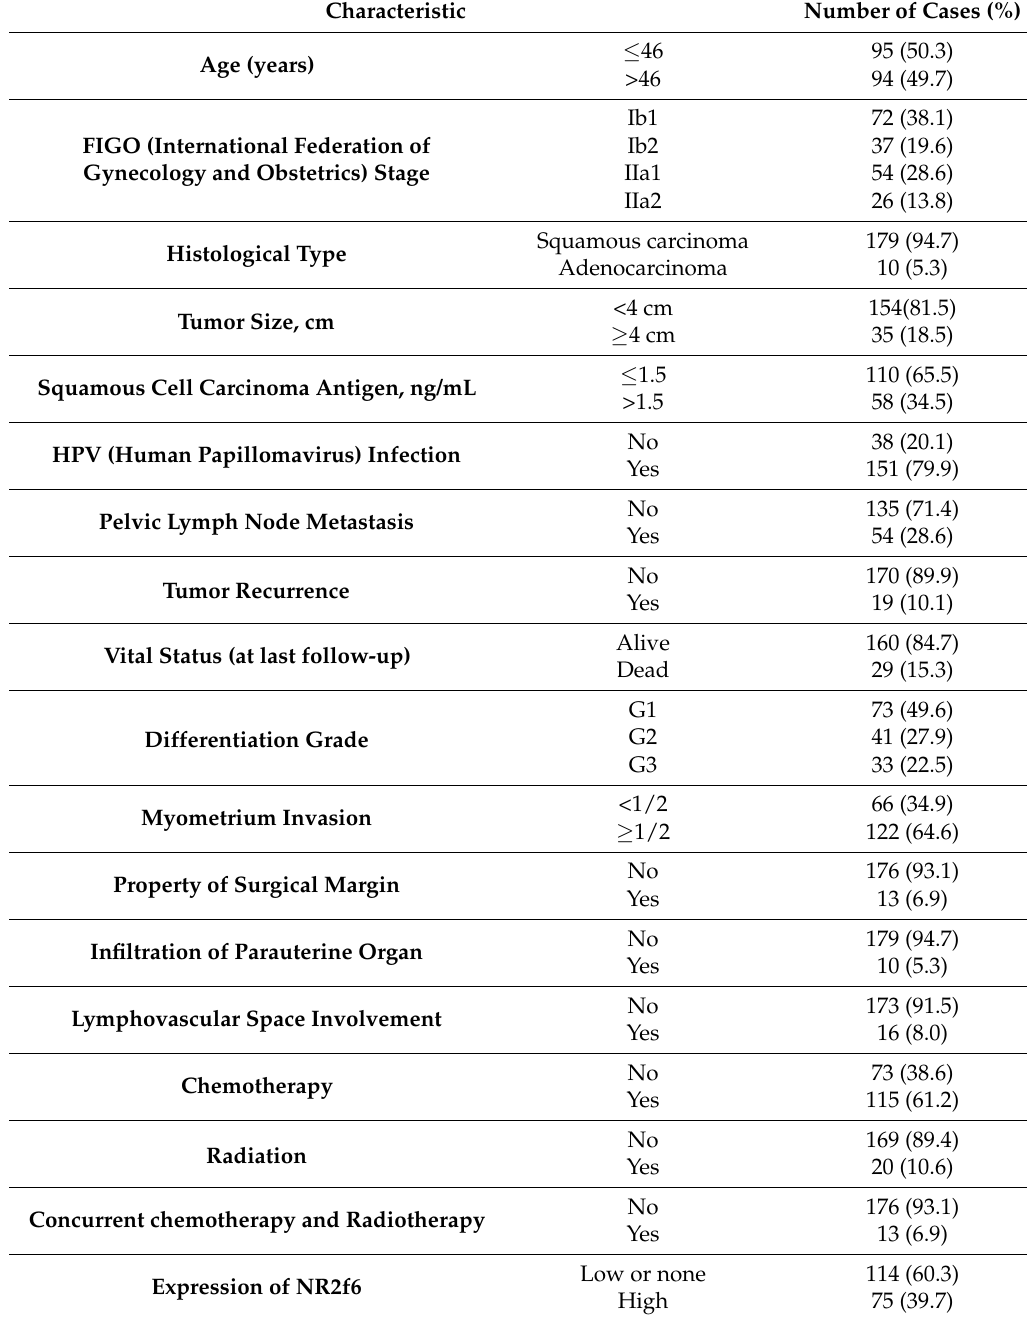
Table 1. Clinicopathological characteristics and tumor expression of NR2F6 in early-stage cervical